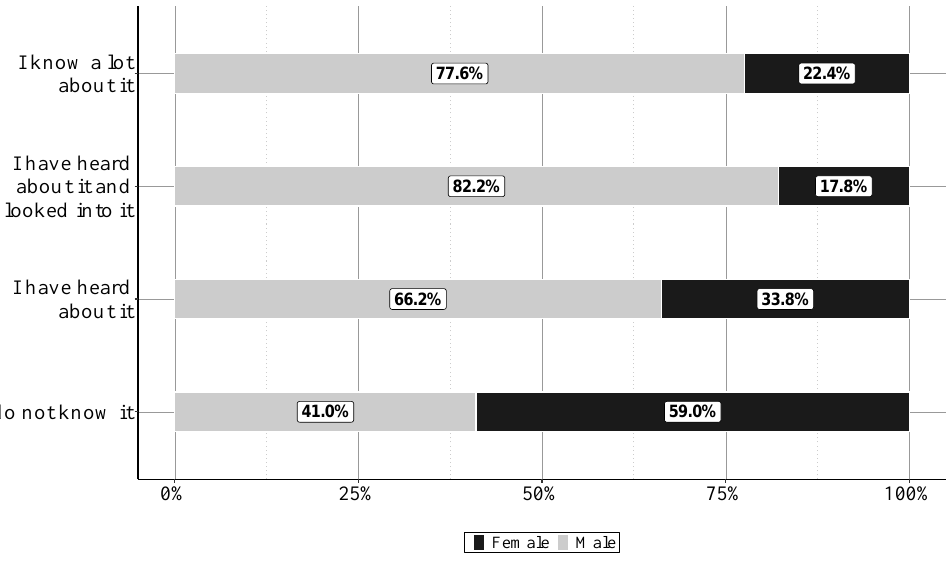
Figure 5. Respondents’ evaluation of mode choice attributes by gender.